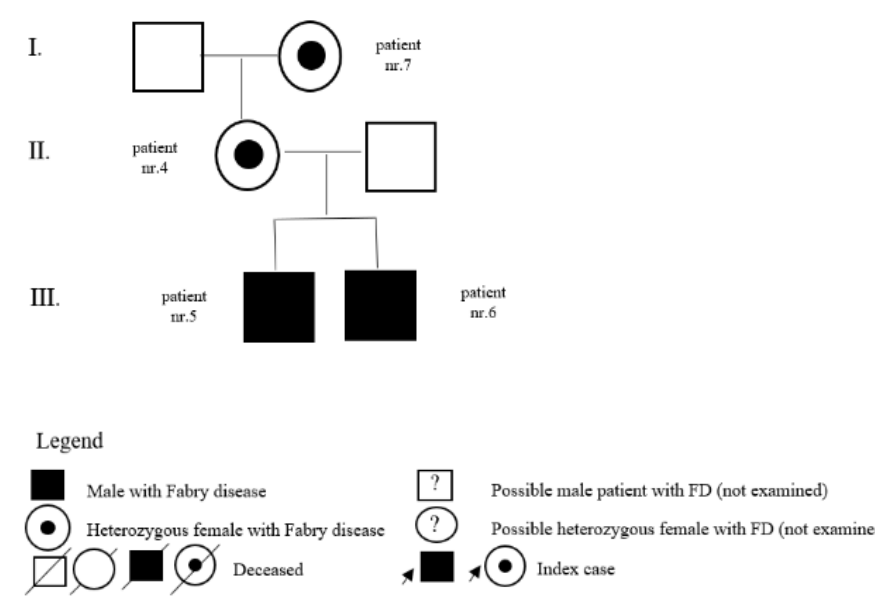
Figure 2. Pedigree of family with mutation c.463G>C.